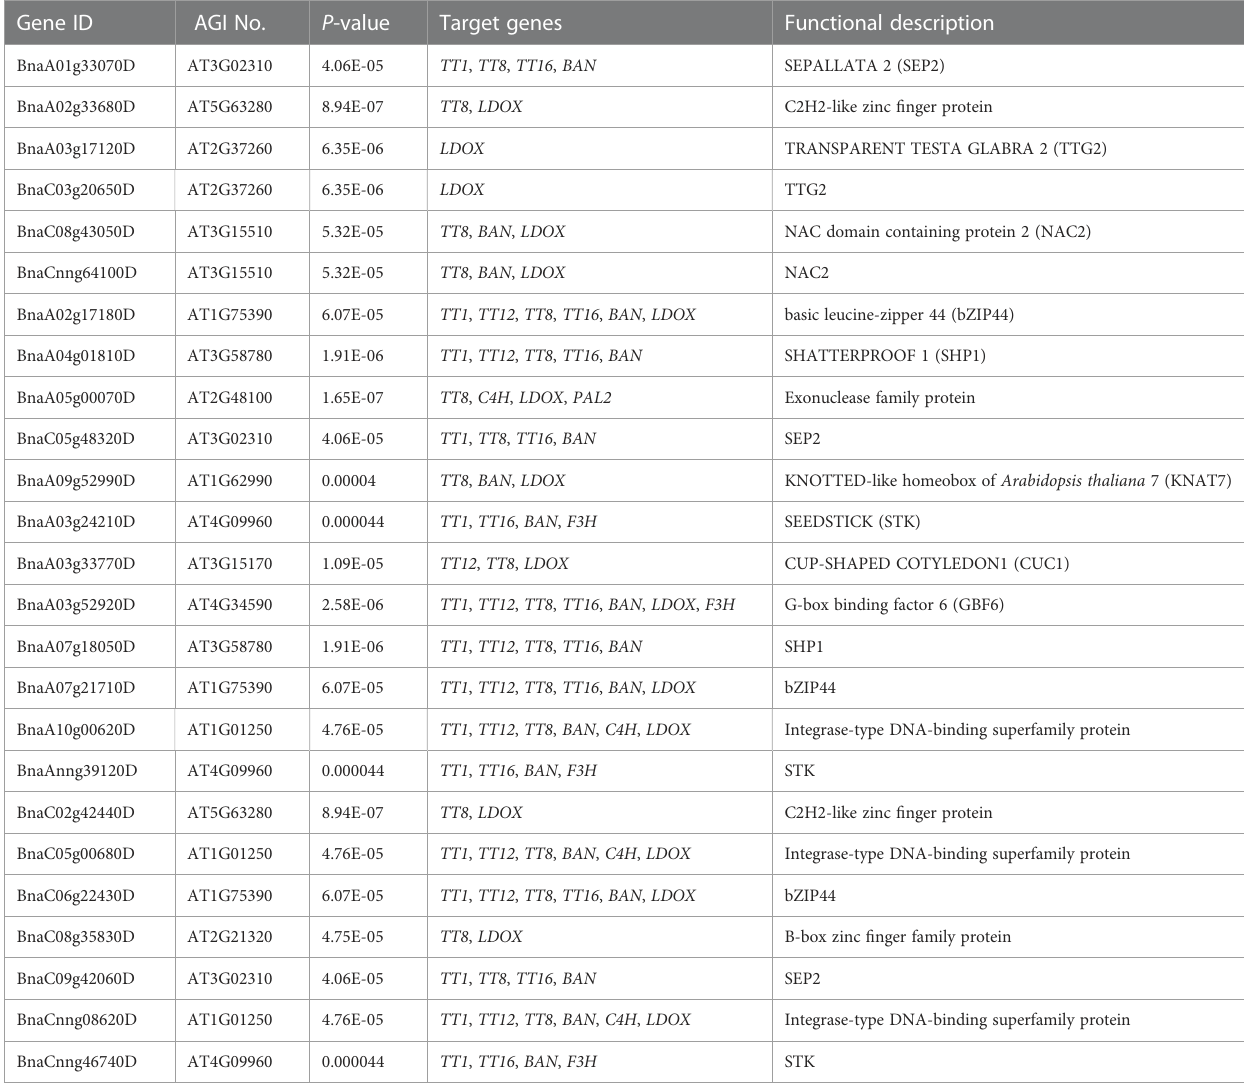
TABLE 3 The predicted 25 transcription factors by iGRN. Gene ID AGI No. P -value Target genes Functional